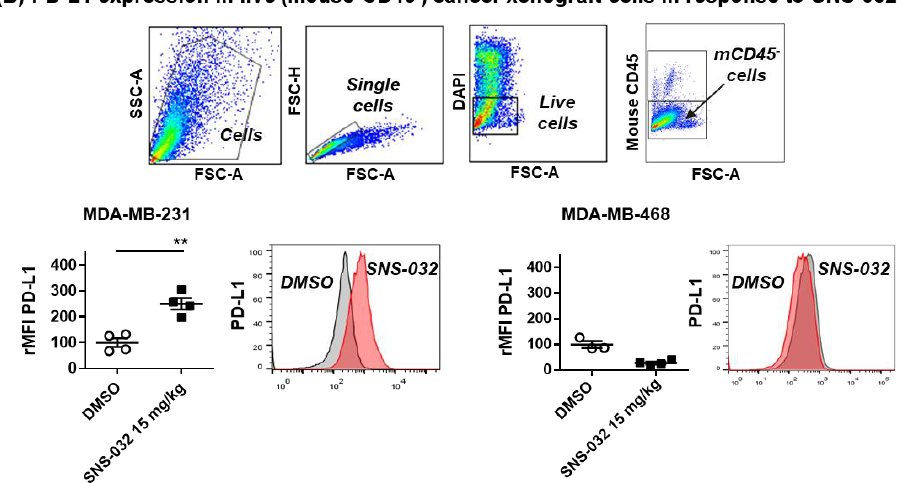
Figure 4. Upregulation of PD-L1 in cell culture and in TNBC xenograft models after SNS-032 treatment. ( A ) TNBC cell lines were treated with 0.2 µ M SNS-032 or DMSO for 48 h and in vitro PD-L1 protein expression levels in live cancer cells were measured by flow cytometry (Top panel: rMFI; Bottom panel: histograms, grey: isotype control; pink: PD-L1) ( n = 3). ( B ) Flow cytometric data analyses demonstrating elevated PD-L1 expression after SNS-032 treatment (15 mg/kg) in live ex vivo MDA-MB-231 cells ( n = 4 mice each), but not in MDA-MB-468 model ( n = 3 mice for DMSO group, n = 4 mice for SNS-032-treated group) Top panel: Flow cytometric gating strategy to select live non-immune cells extracted from human TNBC xenograft models; Bottom panel: PD-L1 expression by rMFI and histograms (grey: isotype control; pink: PD-L1). All p -values were reported with the following associated symbols: p < 0.05 (*), p < 0.005 (**), and all tests were